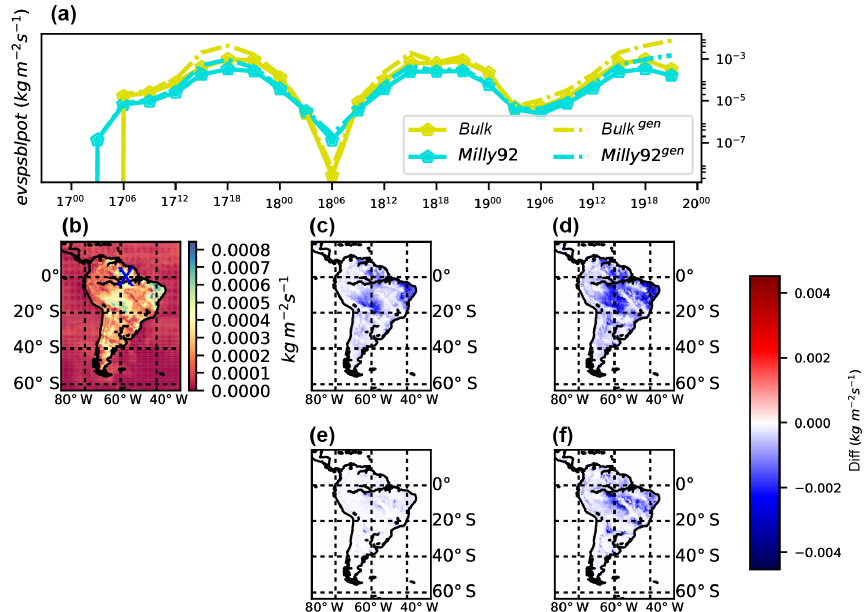
Figure 8. Evolution ( a , in y log scale) of potential evapotranspiration by bulk (yellow) and Milly92 (blue) generic (dashed lines) methods at 4 ◦ 58 (cid:48) 55.524 (cid:48)(cid:48) S, 62 ◦ 4 (cid:48) 37.92 (cid:48)(cid:48) W (blue cross in panel b ). On 18 November 2015 15:00UTC, potential evapotranspiration following Milly correction (b) , differences between the two methods ( c , evspblpot Milly92 − evspblpot bulk ), differences between the two generic methods ( d , − evspblpot gen evspblpot gen ), differences between the Milly method and its generic counterpart ( e , evspblpot Milly92 − evspblpot gen Milly92 bulk and differences between the bulk method and its generic counterpart ( f , evspblpot bulk − evspblpot gen